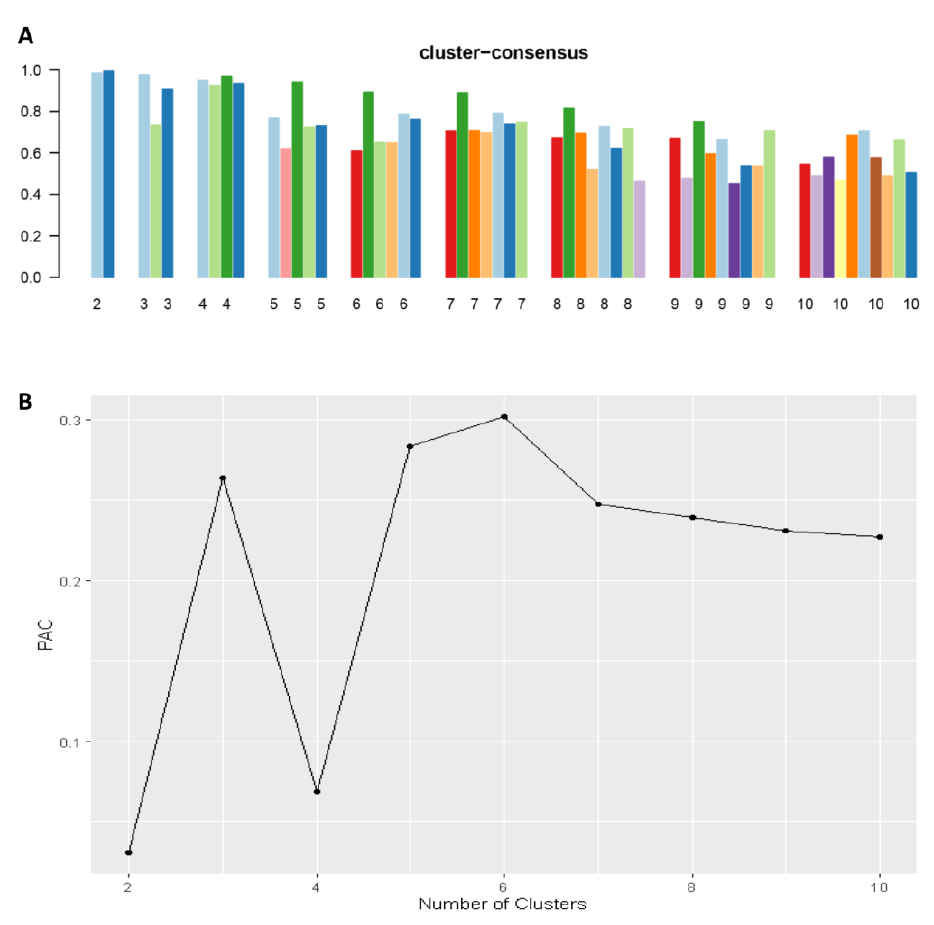
Figure 3. ( A ) The mean cluster consensus score was comparable between a scenario of two or four clusters. ( B ) Favorable low PACs were demonstrated for two and four clusters.